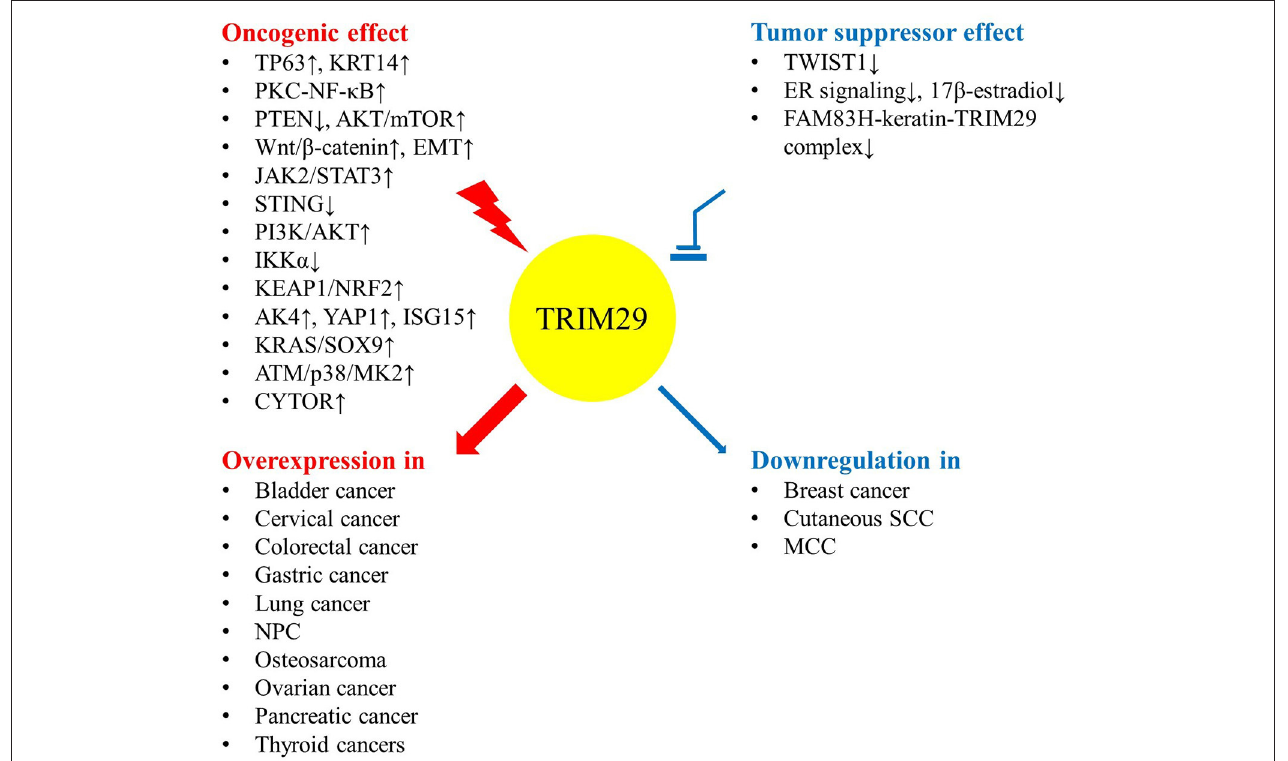
FIGURE 2 | TRIM29 can act as either an oncogene or a tumor suppressor depending on the tumor